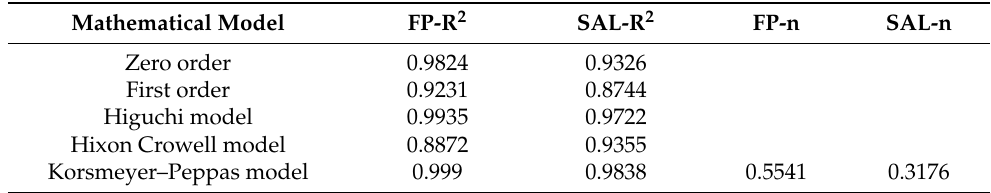
Table 5. The coefficients of determination (R 2 ) as well as the “ n ” value for each mathematical model for FP and SAL .